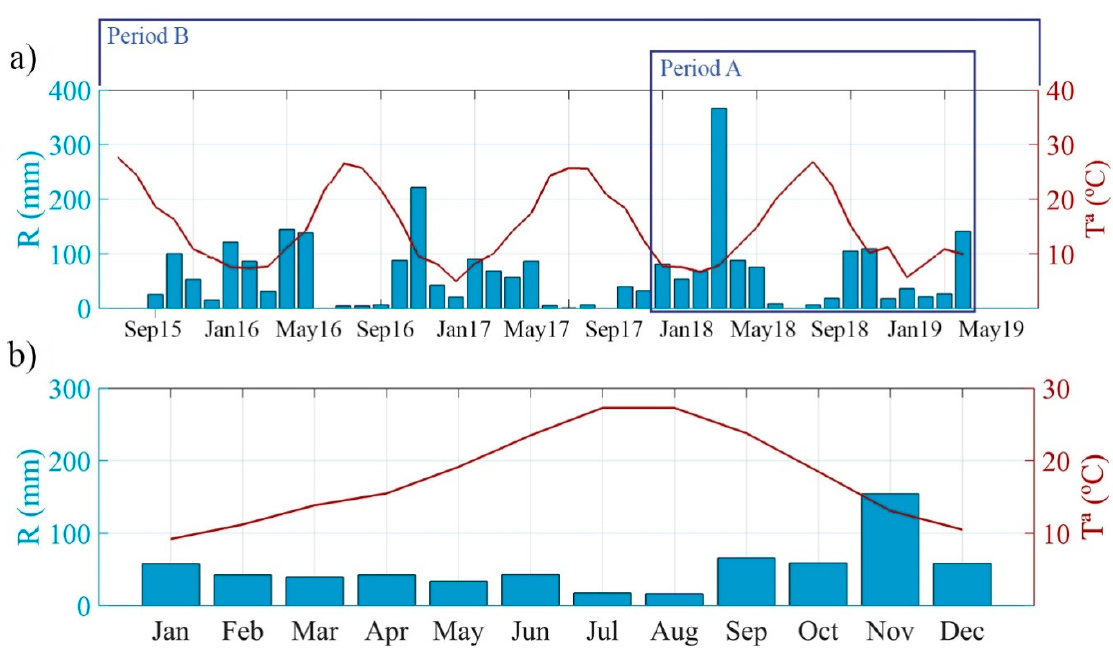
Figure 2. Monthly values of precipitation and average temperature ( a ) during study period B from the weather station in Santa Clotilde, ( b ) from historic data 1971–2000 in Córdoba. The satellite image dataset consisted of 242 granules of Sentinel-2 images. It included all available images with less than 15% of cloud coverage from July 2015 to May 2019. From March 2017 to May 2019, the atmospherically corrected product Level 2A available from ESA (European Space Agency) was used. From July 2015 to March 2017, the images were atmospherically corrected using the module Sen2cor included in SNAP ( ESA Sentinel Application Platform v2.3.0 ). Seven bands were processed to compute the di ff erent vegetation indices used in this study (the central wavelength and the bandwidth are indicated in parentheses): B2 = blue (492 nm; 66 nm), B3 = green (559 nm; 36 nm)), B4 = red (665 nm; 31 nm), B5 = red edge 1 (704 nm; 15 nm), B6 = red edge 2 (740 nm; 15 nm), B7 = red edge 3 (783 nm; 20 nm) and B8 = near infrared (NIR) (833 nm; 106 nm).